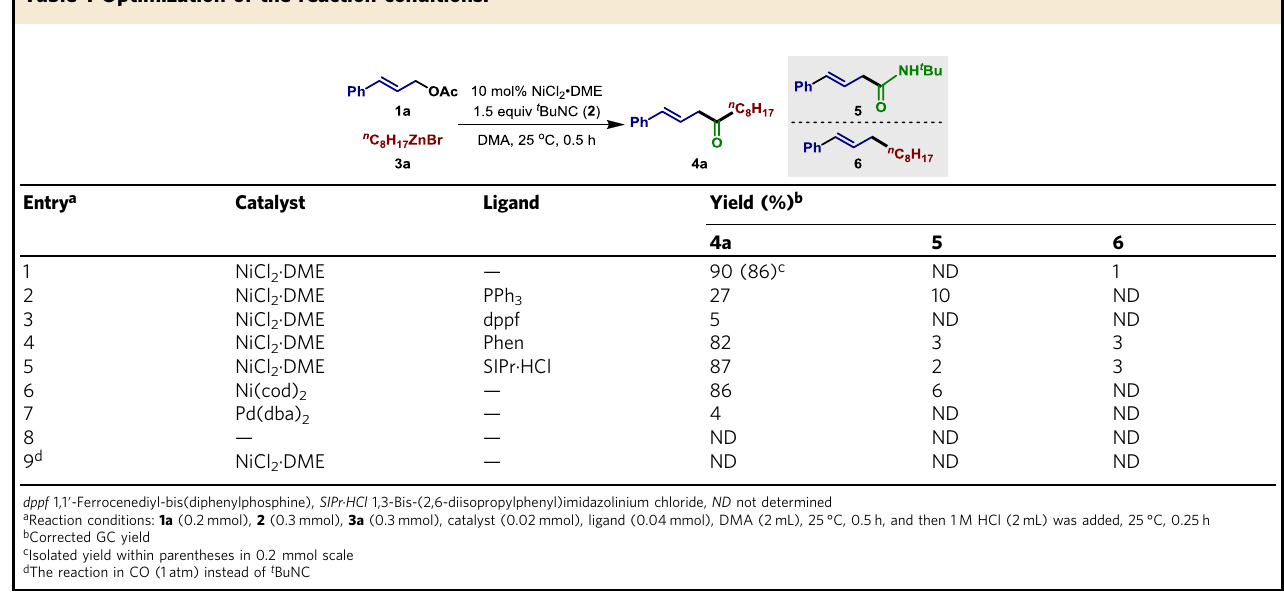
Table 1 Optimization of the reaction conditions.